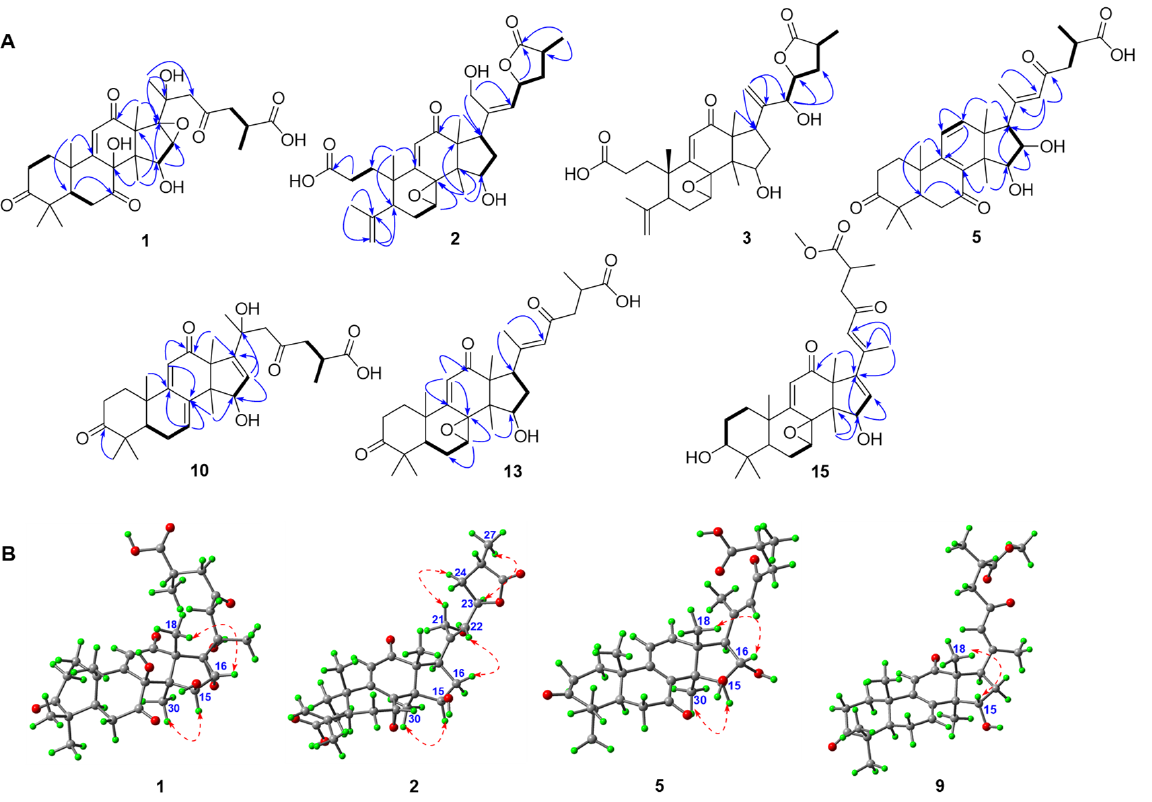
Figure 2. ( A ) Selected HMBC (H → C) and 1 H- 1 H COSY (H H) correlations of compounds 1 – 3 , 5 , 10 , 13 , and 15 . ( B ) Selected ROESY correlations of compounds 1 , 2 , 5 , and 9 .